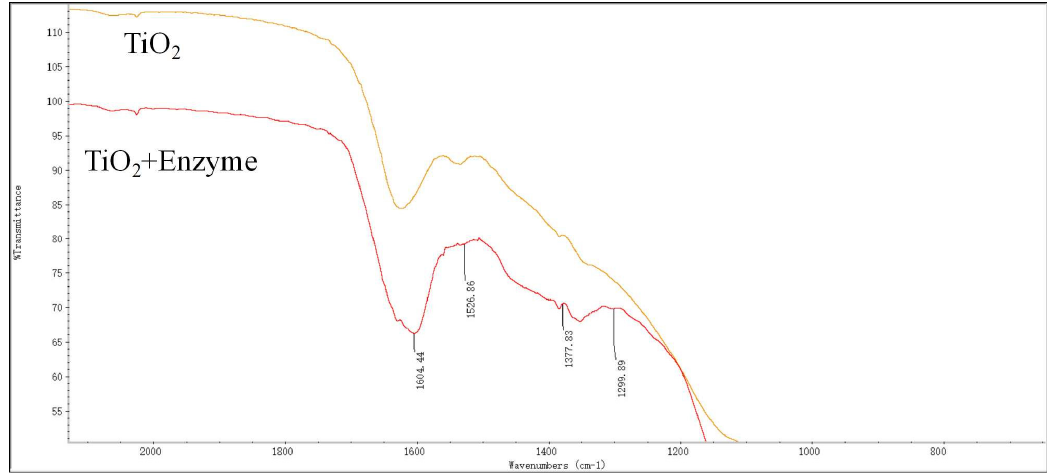
Figure A1. Drawing FT-IR spectra of immobilized enzyme by Omnic software.